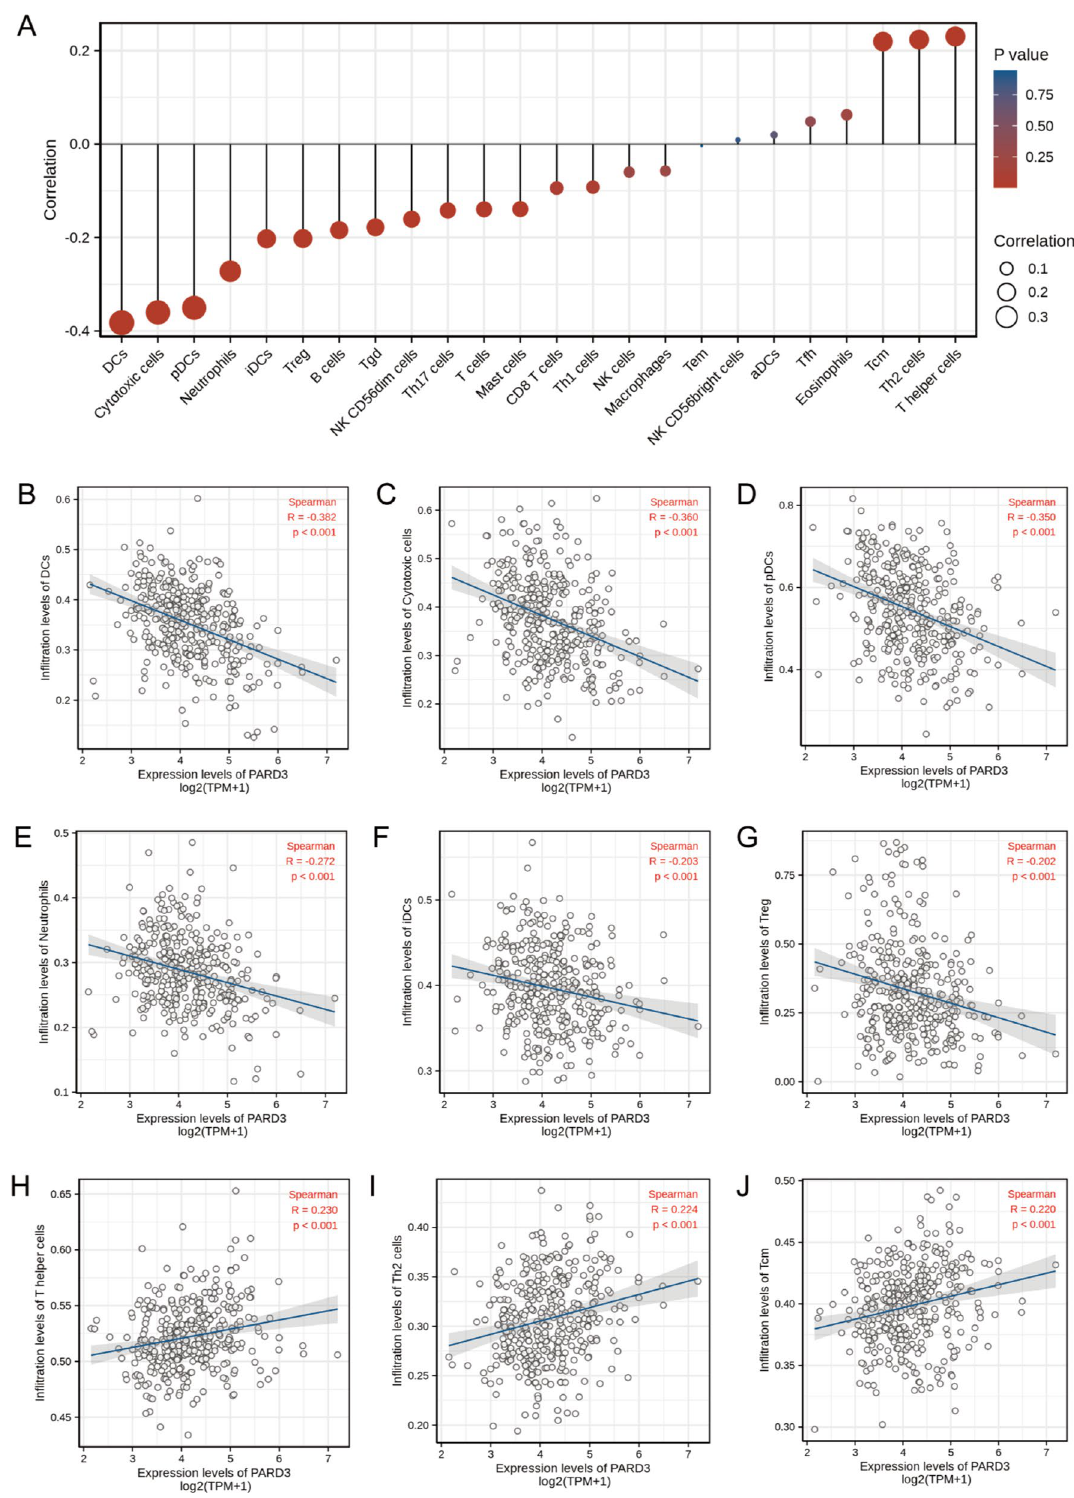
Figure 6. Association of PARD3 with immune infiltration. ( A ) Association of PARD3 with immune infiltration ( DCs dendritic cells, pDCs plasmacytoid DCs, iDCs immature DCs, aDCs activated DCs, Treg regulatory T cells, Tgd T gamma delta, Th helper T cells, Tfh T follicular helper, NK natural killer, Tem T effector memory, Tcm T central memory). ( B – G ) PARD3 was negatively related to infiltration of DCs, cytotoxic cells, pDCs, neutrophils, iDCs, and Treg ( p < 0.01). ( H – J ) PARD3 was positively related to in infiltration of T helper cells, Th2 cells, and Tcm ( p <